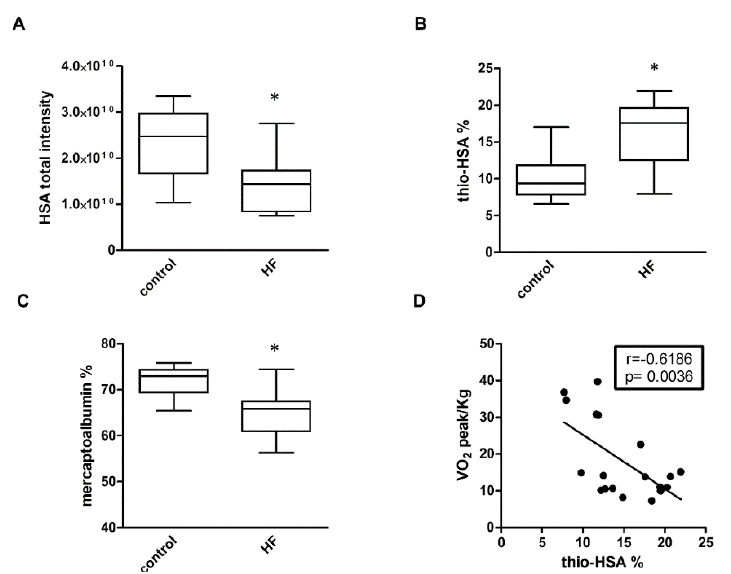
Figure 1. Thiolated albumin in heart failure (HF) patients. Total HSA ( A ), percentages of thiolated albumin ( B ), and mercaptoalbumin ( C ) in plasma of controls and HF patients. * p < 0.05 vs. control. ( D ) Correlation between thio-HSA and peak VO 2 .